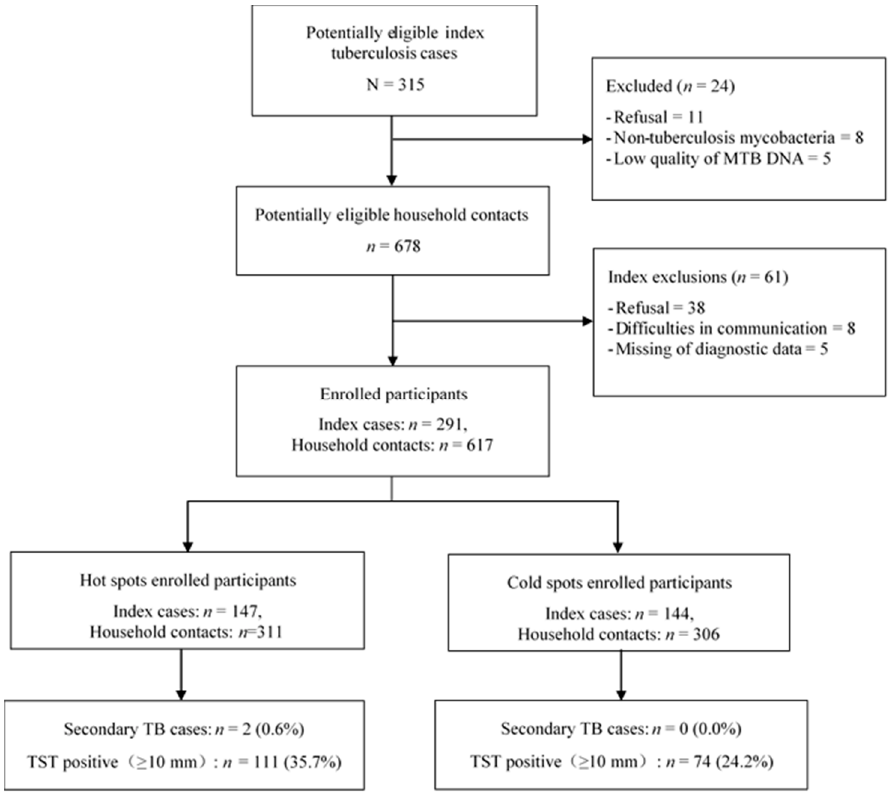
Figure 2. Profile of household Mtb transmission study.